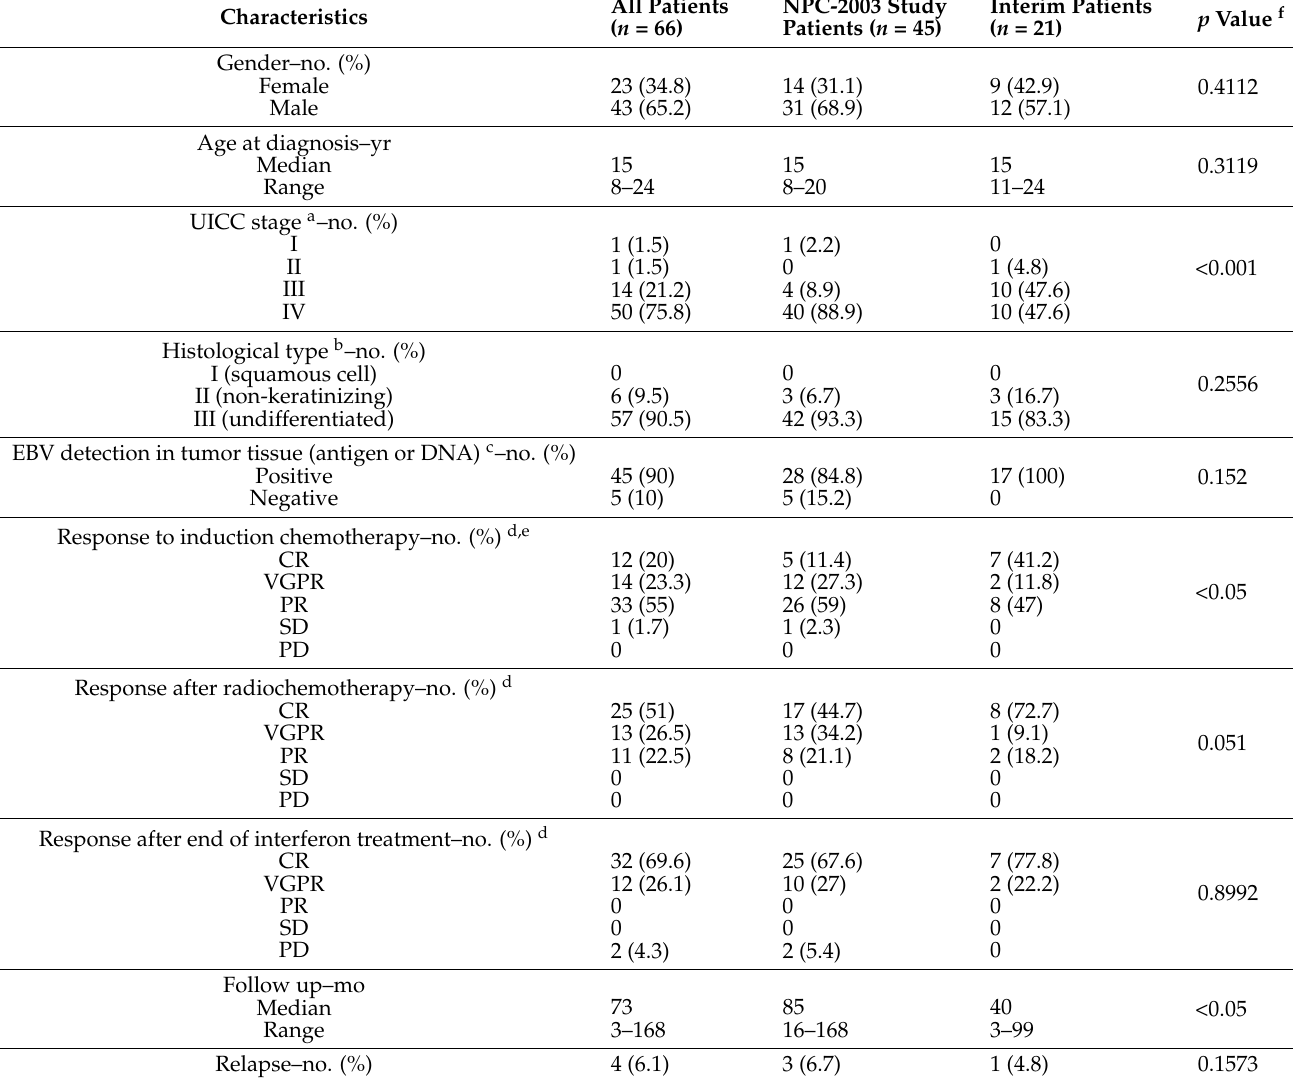
Table 1. Patient characteristics of the NPC-2003 study and interim